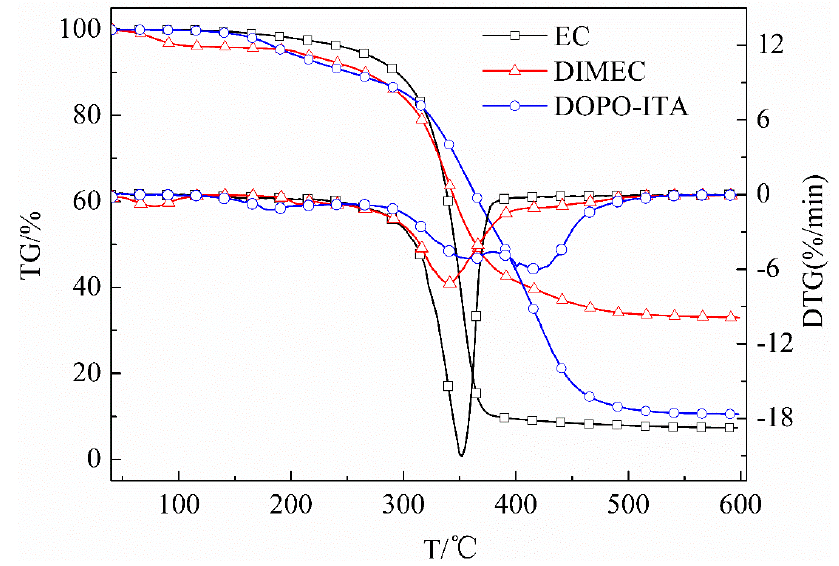
Figure 7. TG and DTG of DIMEC and EC.